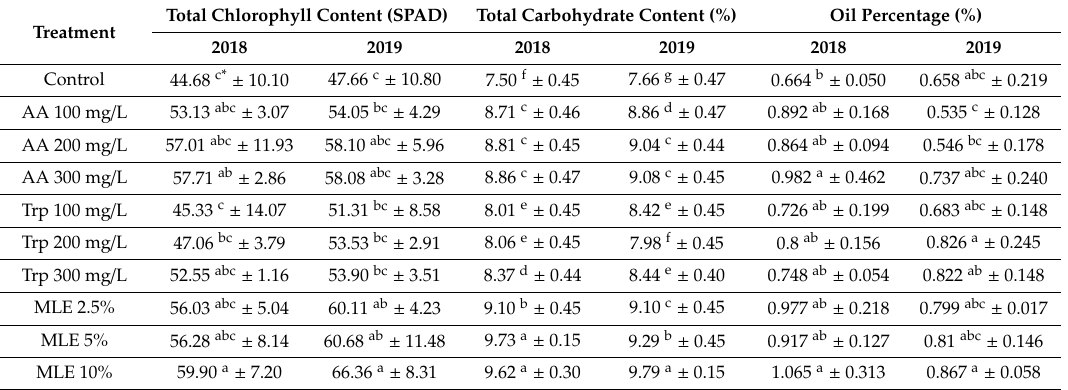
Chemical parameters of O. majorana plants treated with AA, Trp and MLE in two successive